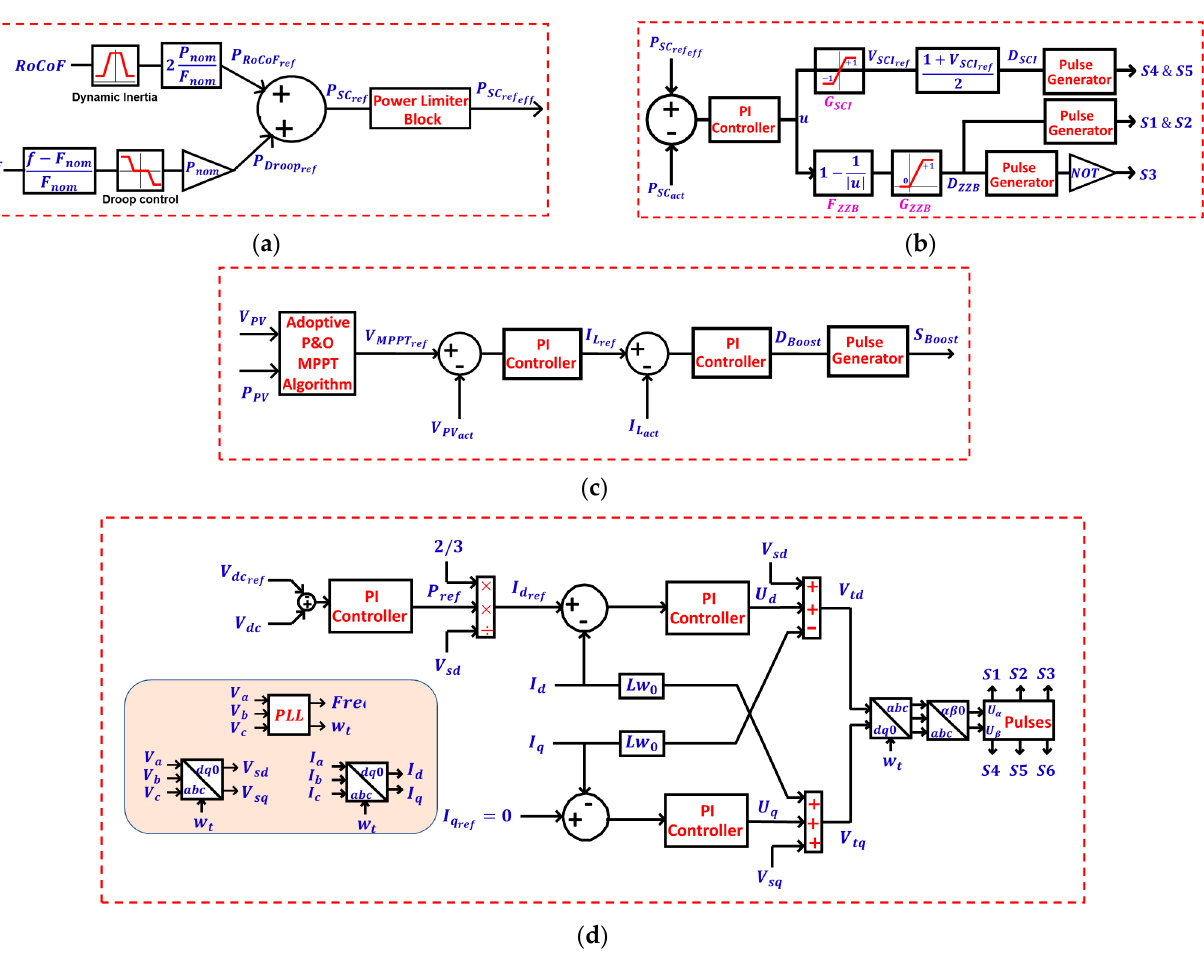
Figure 12. Implemented control schemes for the proposed PSCT: ( a ) outer reference power-generation loop for SC-PPS; ( b ) inner control loop to decouple ZZB operation from SCI; ( c ) MPPT control for Boost converter; ( d ) DC-link voltage and grid side PQ control for VSI.